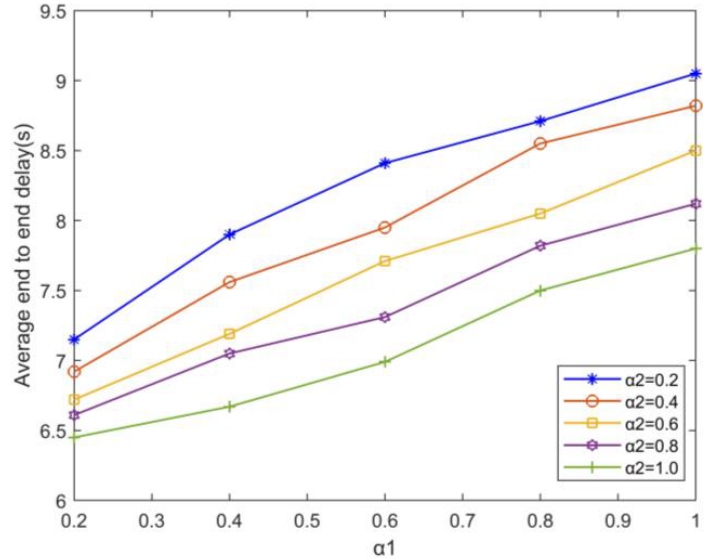
Figure 7. Average end-to-end delay of α 1 and α 2 (CR = 1500 m).